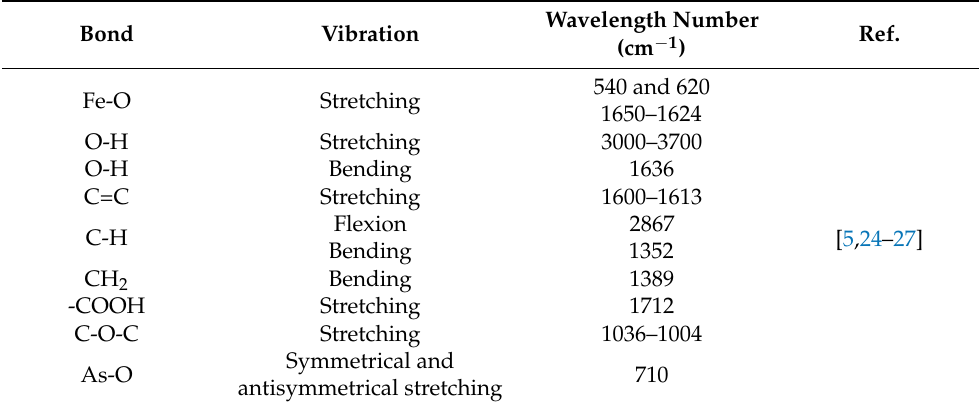
Figure 6. FTIR spectra for ( a ) nZVI, ( b ) nZVI/GO, ( c ) decorated nZVI/GO jute fibers after arsenic ions absorption and ( d ) jute fibers. Table 2. With FTIR vibrations at different wavelength numbers.